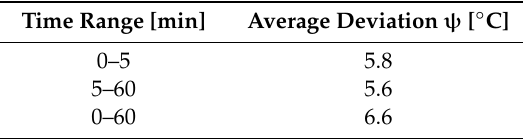
Table 6. Average deviation Ψ between the measured and theoretical temperatures in relations to the assumed time range for all analyzed